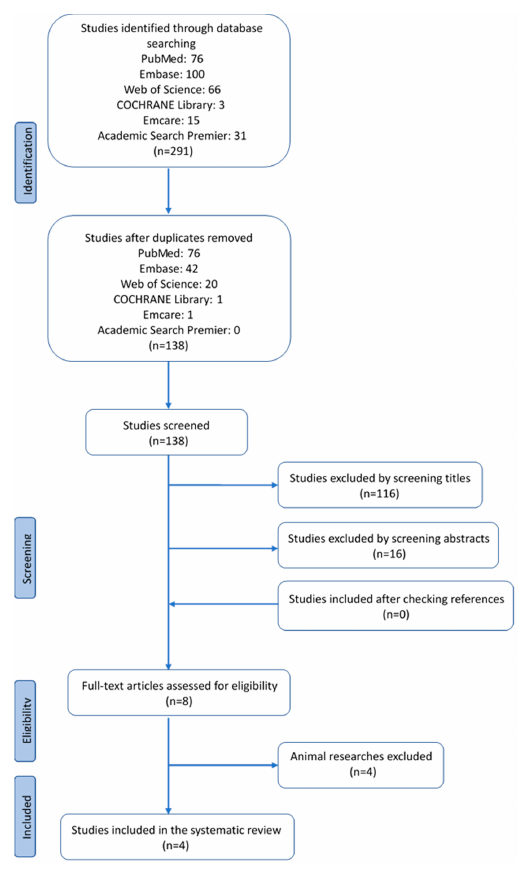
Figure 1. Four articles met all inclusion criteria and were included in the systematic review. Eight articles were identified to assess the full text for eligibility, four of which were animal studies. Therefore, in the end, four articles met all the inclusion criteria and were included in this systematic review. Table 1 shows the main characteristics of the four studies included in this systematic review. All studies were performed after 2010. One out of the four studies did not have a naturally conceived control group [71]. In this study, they compared OD cases with and without a distinct lesion. All studies, except for Nakabayshi et al. [72], included vaginal deliveries and caesarean sections. Two